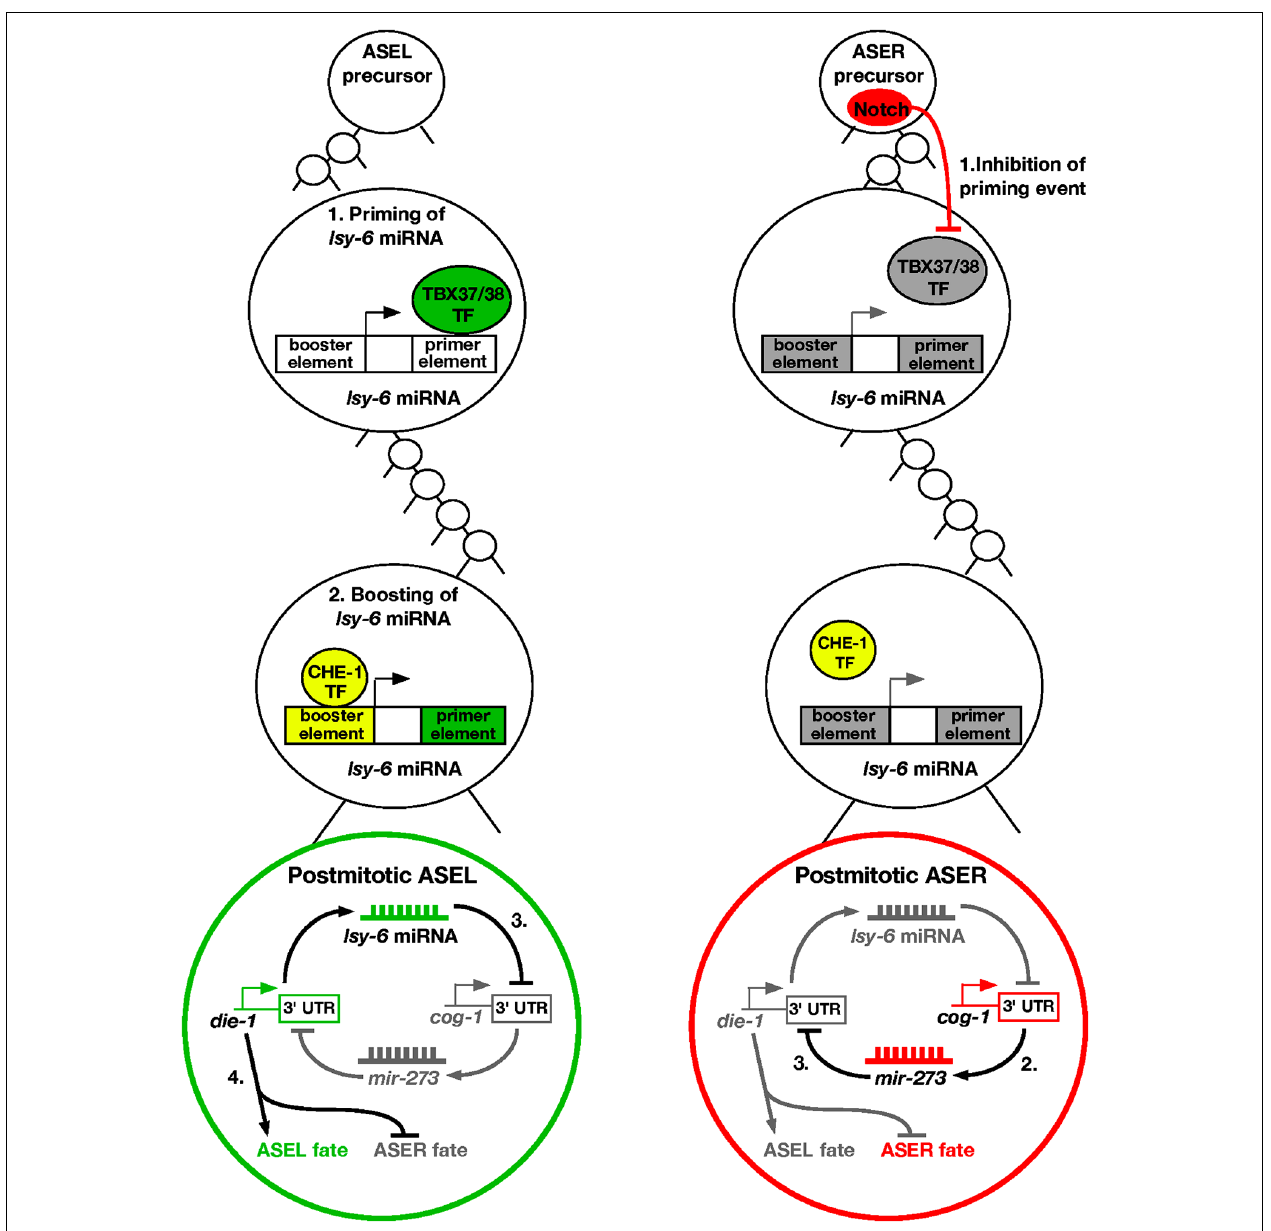
the ASEL promoting transcription factor DIE-1 to be expressed. (4) DIE-1 then activates ASEL effector genes and represses the ASER cell fate. ASER: (1) Notch is expressed in the ASER precursor and inhibits the lsy-6 priming event.Therefore, the lsy-6 miRNA expression level cannot be boosted as the chromatin remains compact. (2) Consequently, in the postmitotic ASER neuron, the COG-1 transcription factor is expressed, which activates another miRNA, mir-273 . (3) mir-273 directly inhibits the ASEL promoting transcription factor DIE-1, and therefore promotes the ASER